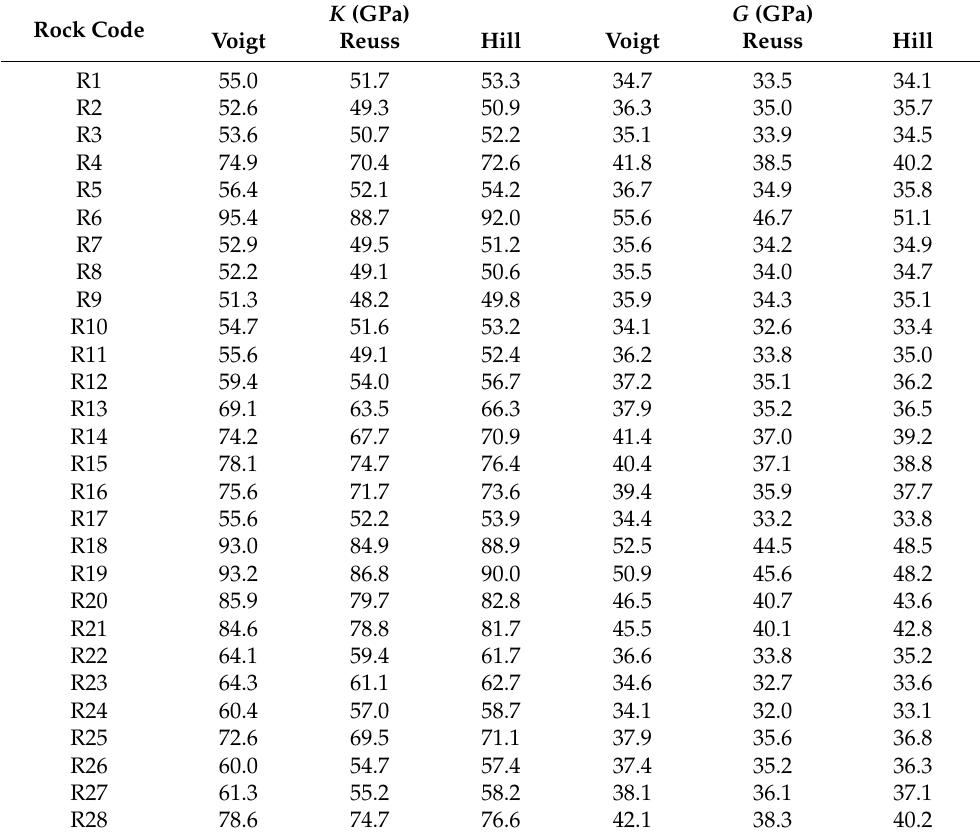
Table 3. Bulk and shear moduli of the solid phase of the studied rocks calculated using the Voigt– Reuss–Hill